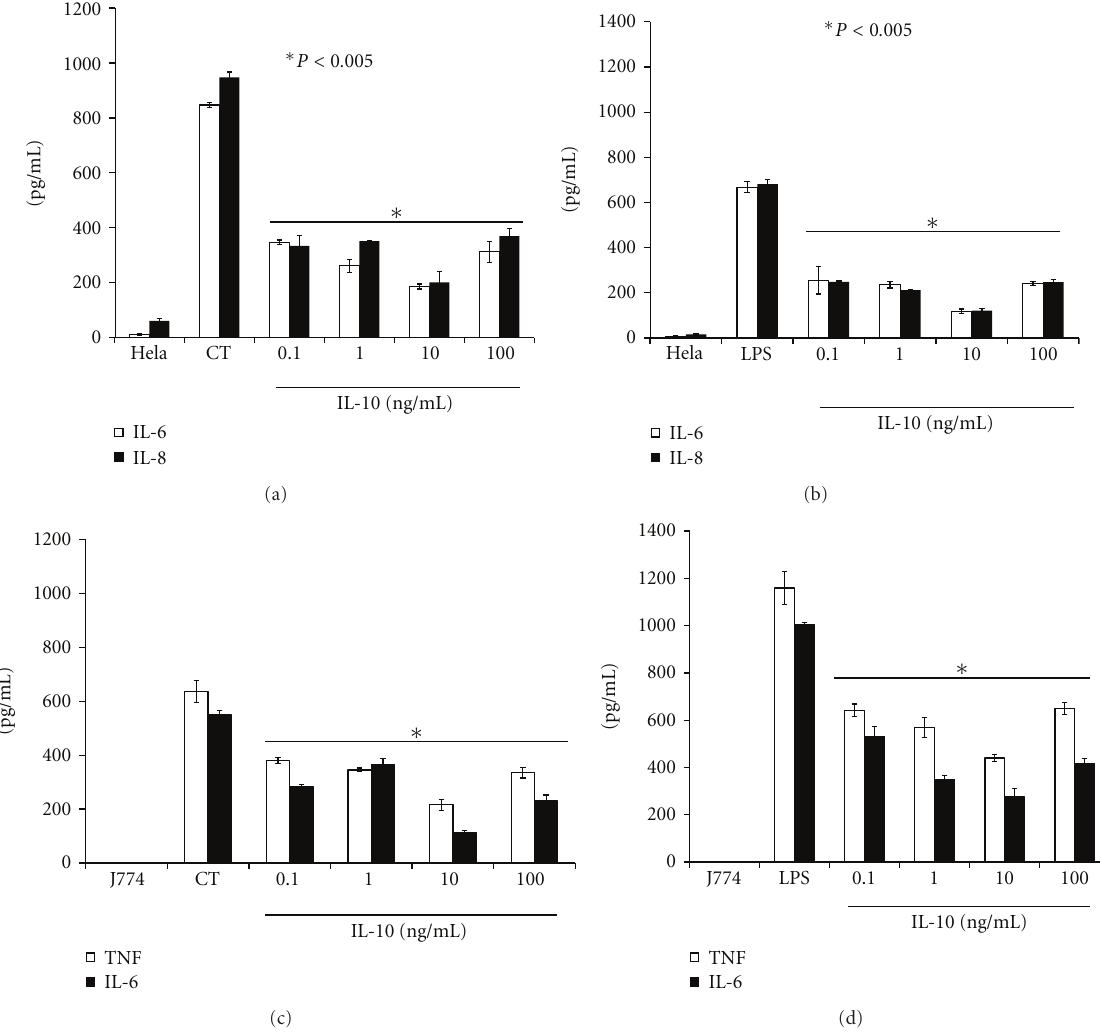
Figure 5: Recombinant IL-10 downregulates the production of IL-6, IL-8, and TNF in C. trachomatis- (CT-) infected J774 and HeLa cells. HeLa or J774 cells (10 5 cells/mL/well) were seeded in 24-well plates and 24 hr later, cells were infected with C. trachomatis EBs (10 4 IFU/well). After 2 days infection, various concentrations of recombinant IL-10 were added to cell cultures and supernatants were collected 1 day later to quantify the levels of human IL-6 and IL-8 (a) and mouse IL-6 and TNF (b) by ELISA. For positive control, HeLa and J774 cells were stimulated for 24 hr with LPS in the presence of various concentrations of IL-10, and human IL-8 and IL-6 (b) and mouse IL-6 and TNF (d) were determined from collected supernatants by ELISA. Asterisk indicates significant di ff erence ( P < 0 . 005) and P values were calculated by use of Student’s t- test. Each bar represents the mean ± SD of samples run in duplicates. The data are representative of two separate